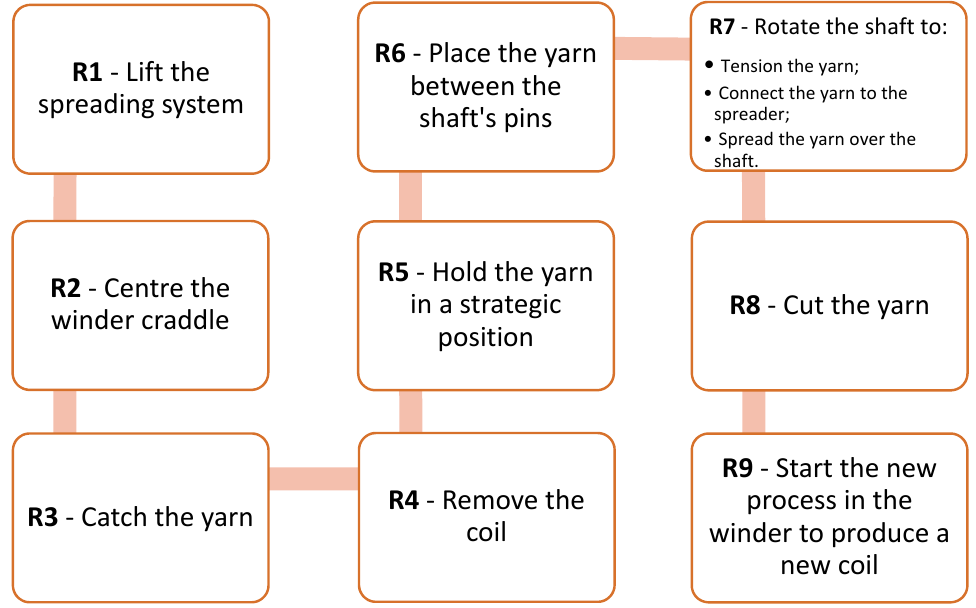
Figure 2. Diagram with the sequence of actions needed for the coil removal.